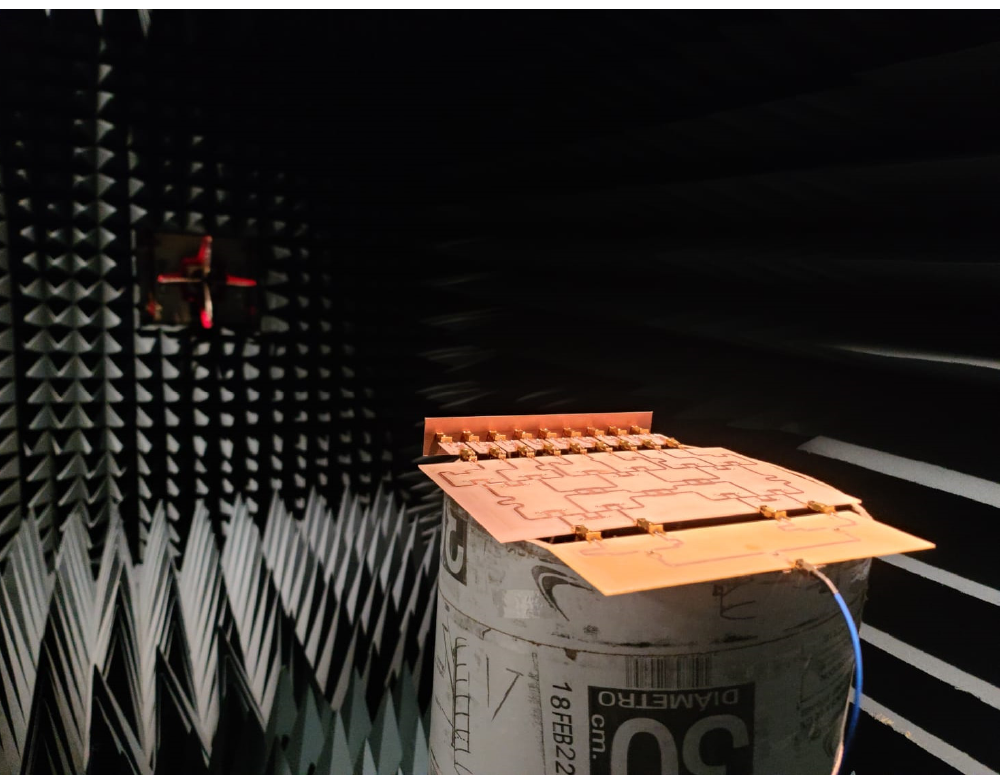
Figure 12. P rototype of the full system measured experimentally in a far field anechoic Figure 12. Prototype of the full system measured experimentally in a far field anechoic chamber. chamber.